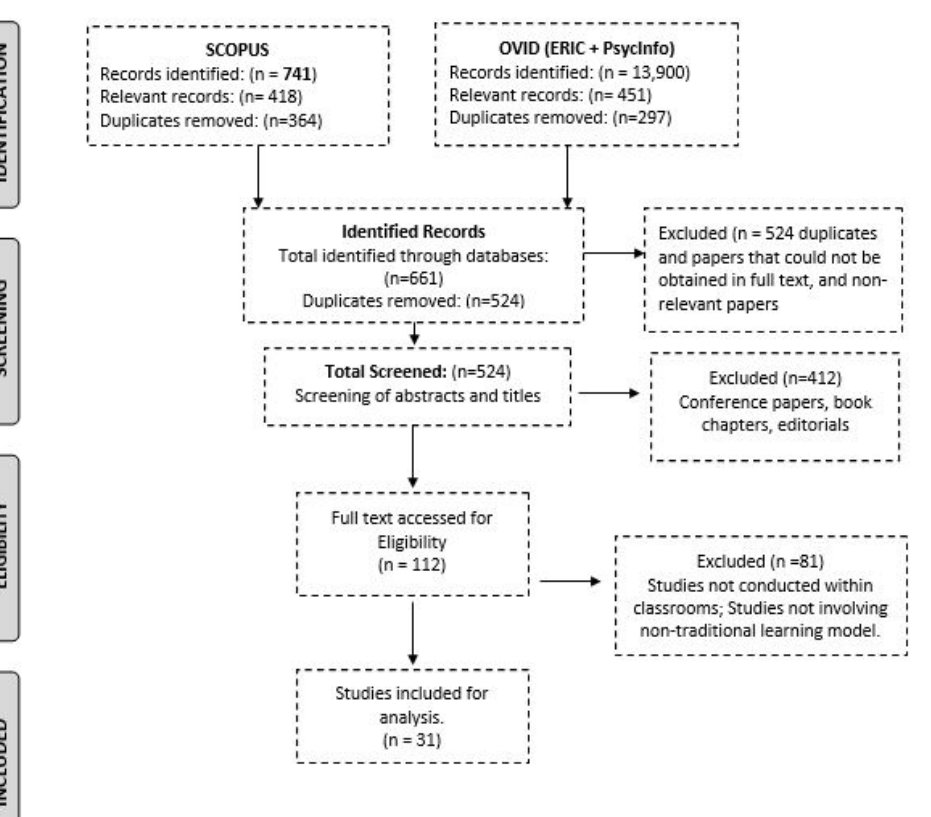
Figure 1. PRISMA Flow diagram to summarize the study selection.